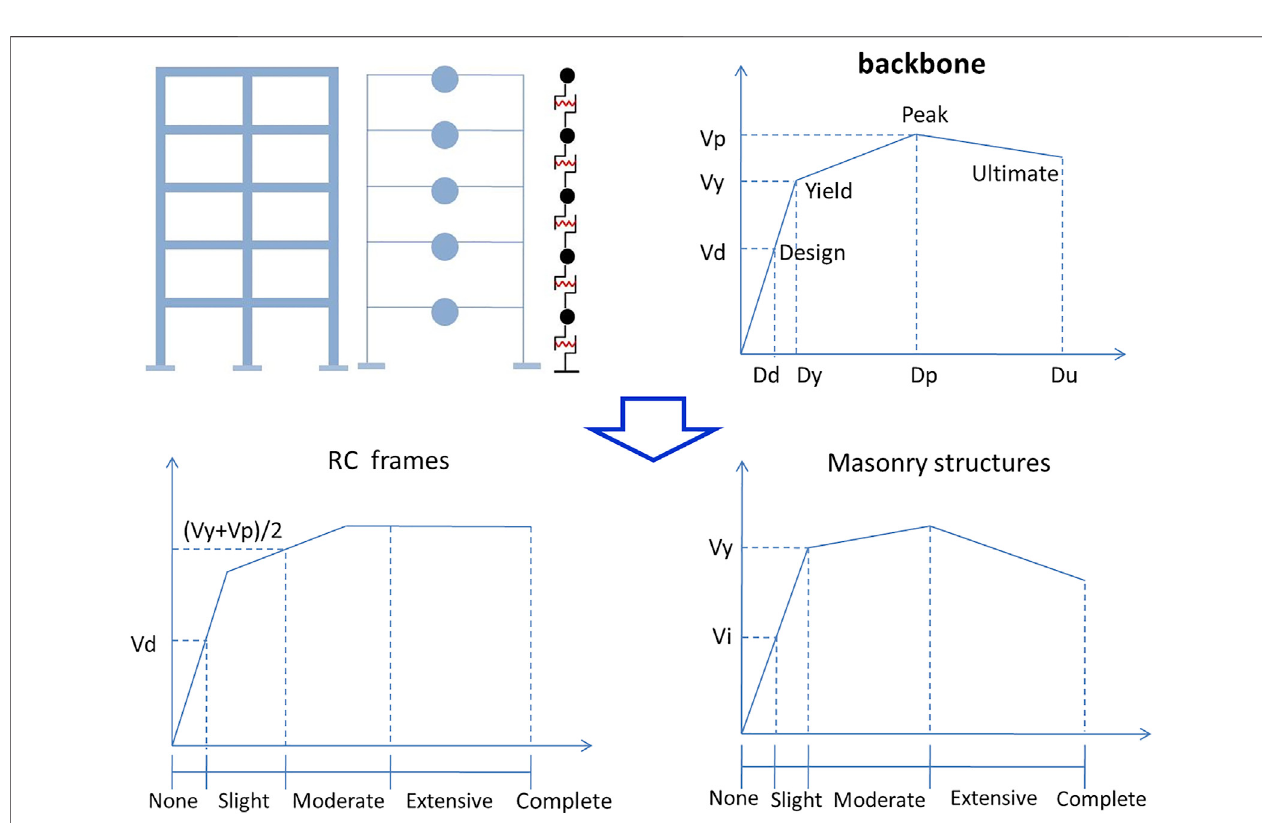
FIGURE 6 | Time-duration dynamic analysis and damage assessment model for buildings.